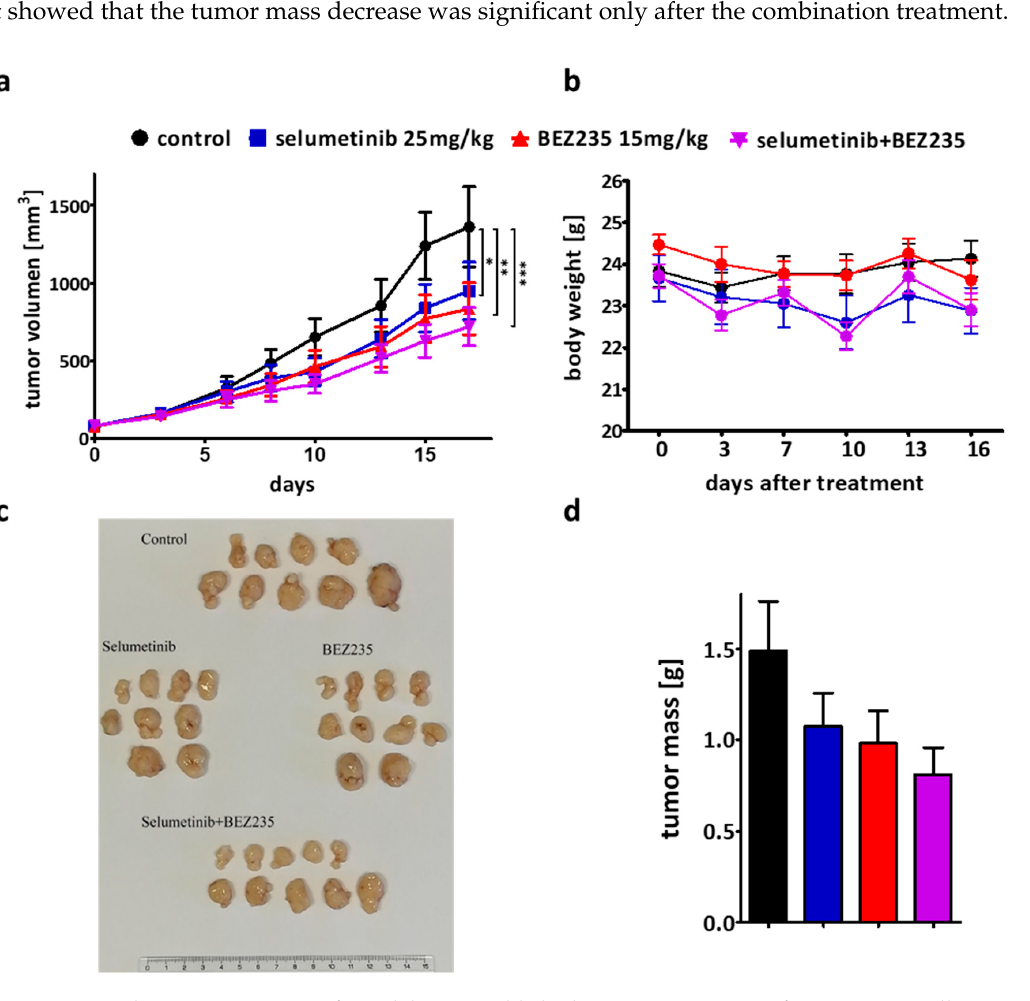
Figure 6. Subcutaneous xenograft model was established in NOD-SCID mice from SW1417 cells to determinate the effect of the single treatment and combinational therapy. Daily oral treatment of selumetinib (25 mg/kg) and BEZ235 (15 mg/kg) and the combination of them was used for 17 days.